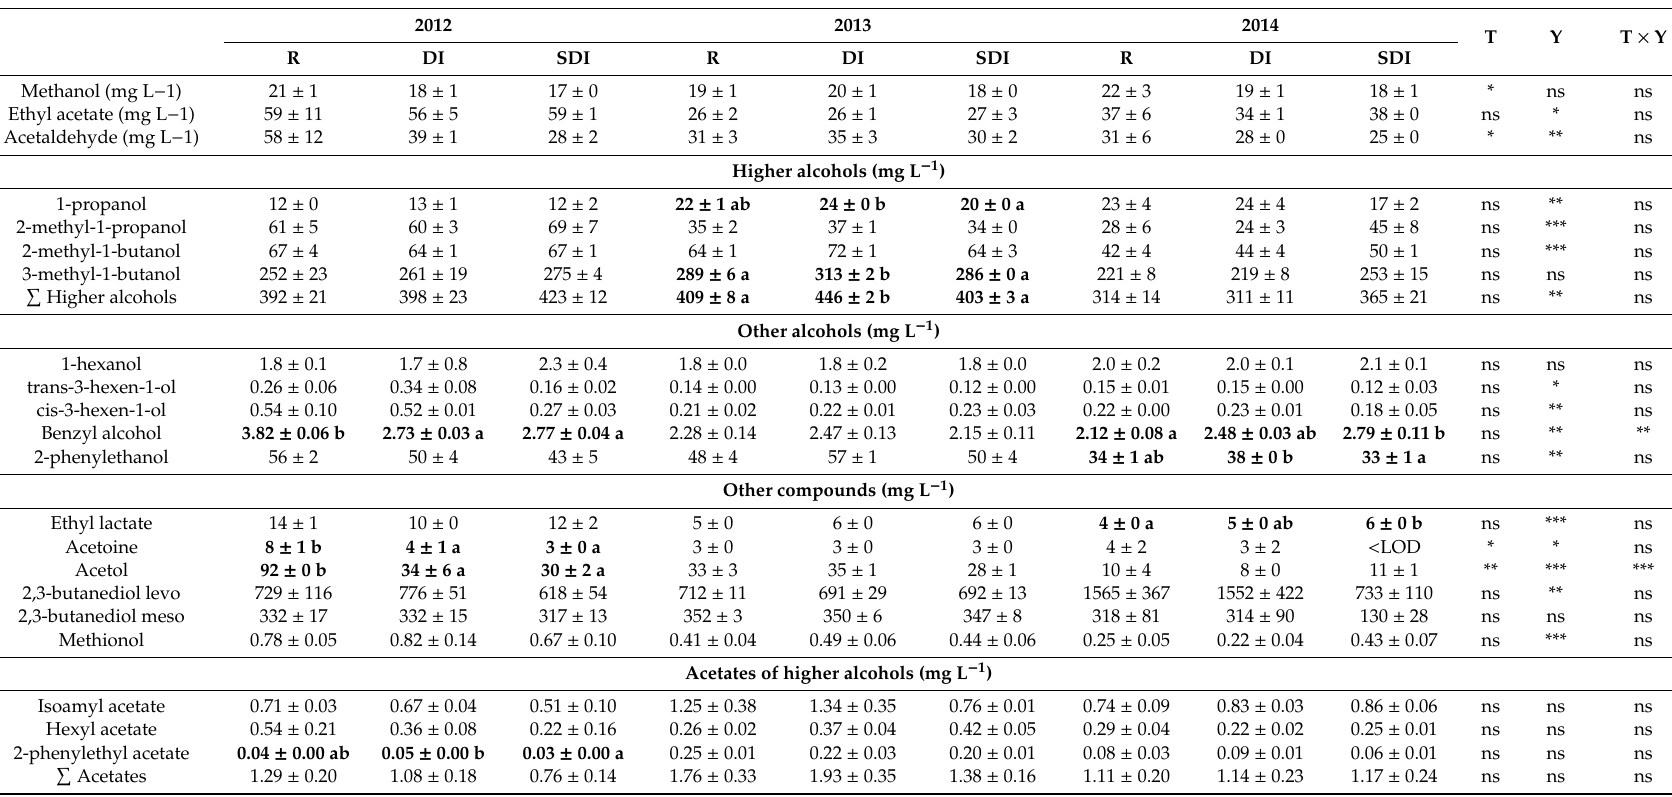
Table 6. Irrigation e ff ects on the concentrations of volatile compounds (mean ± standard error) of Godello wines. The significances of the year, treatment as well as their interaction are also shown. R = rain-fed, DI = drip irrigation, SDI = subsurface drip irrigation, T = Treatment, Y =